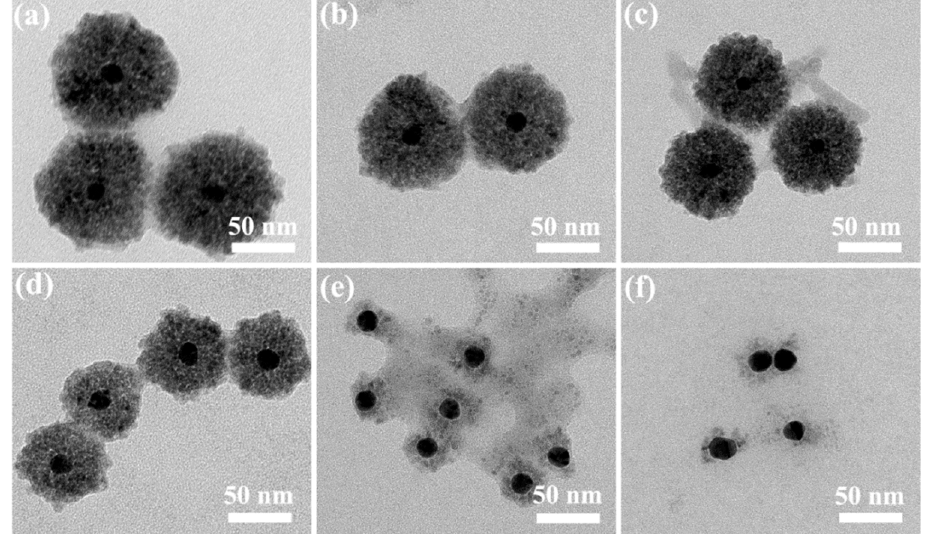
Figure 2. TEM images of AC-1 NCs ( a ), AC-3 NCs ( b ), AC-5 NCs ( c ), AC-7 NCs ( d ), AC-9 NCs, ( e ) and AC-11 NCs ( f ).